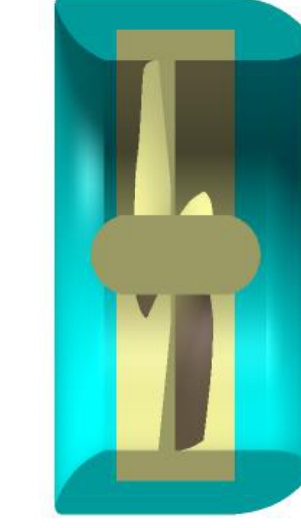
Table 9. Comparison of the simulation results between the prototype RDT and optimized